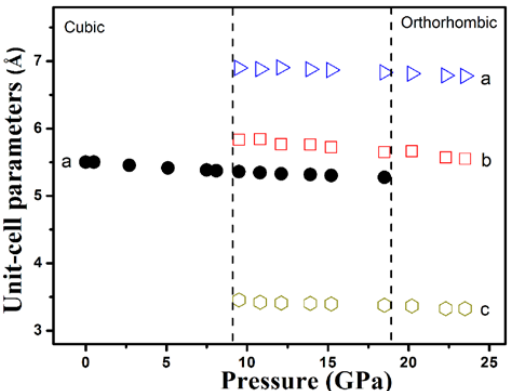
Figure 4. Pressure dependence of the lattice parameters in CaF 2 nanocrystals. Filled symbols denote cubic fluorite structure. Open symbols denote the orthorhombic PbCl 2 -type structure.